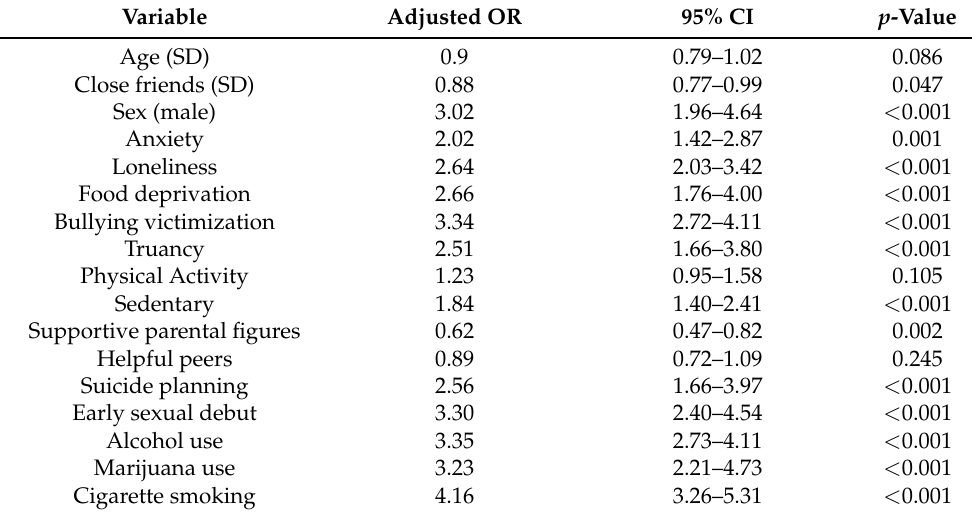
Table 3. The distribution of selected factors according to categories of physical fighting among school-attending adolescents in Mauritius, GSHS 2017.